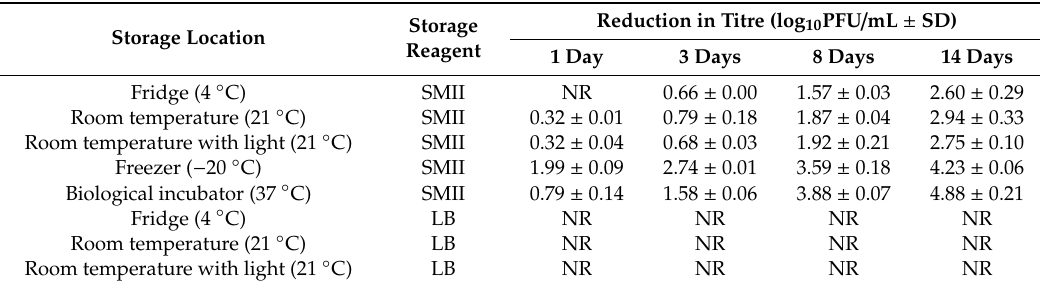
Table 5. Logarithmic reduction in bacteriophage vPhT2 after storage in SM bu ff er II or LB for 14 days in di ff erent temperature and light